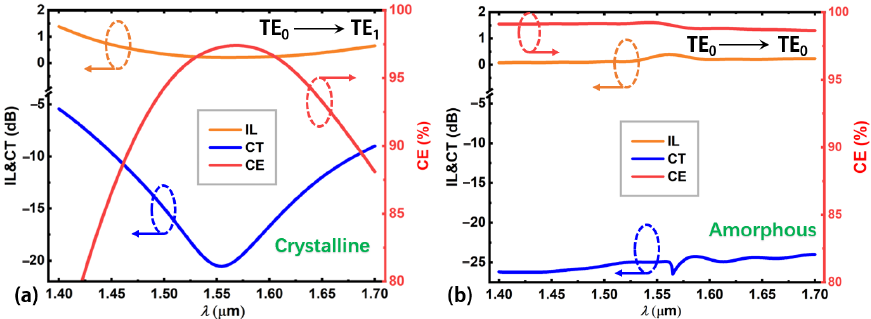
Figure 6. The mode CE, CT, and IL versus wavelength of the proposed mode converter working at the ( a ) crystalline sate and ( b ) amorphous state. The wavelength range is from 1.4 to 1.7 μm.